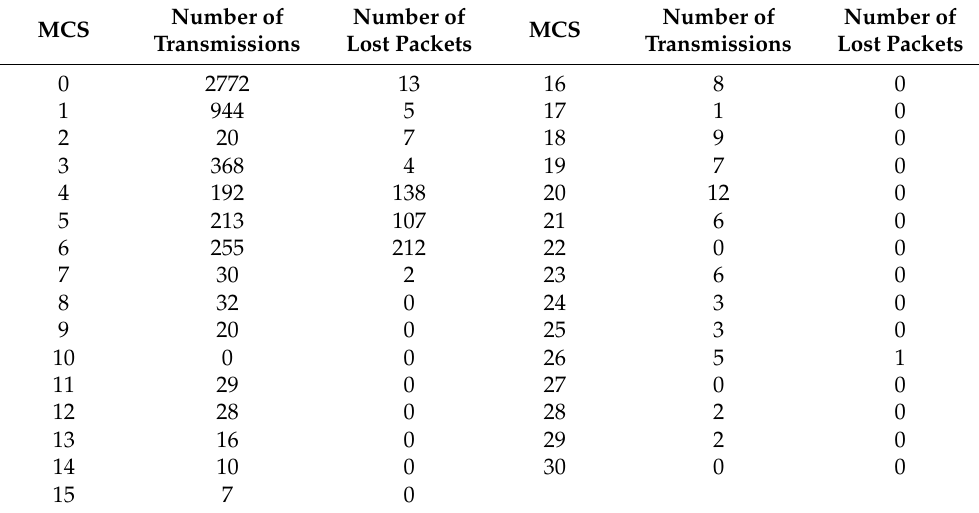
Table 1. The number of realized transmissions and lost packets for each MCS.